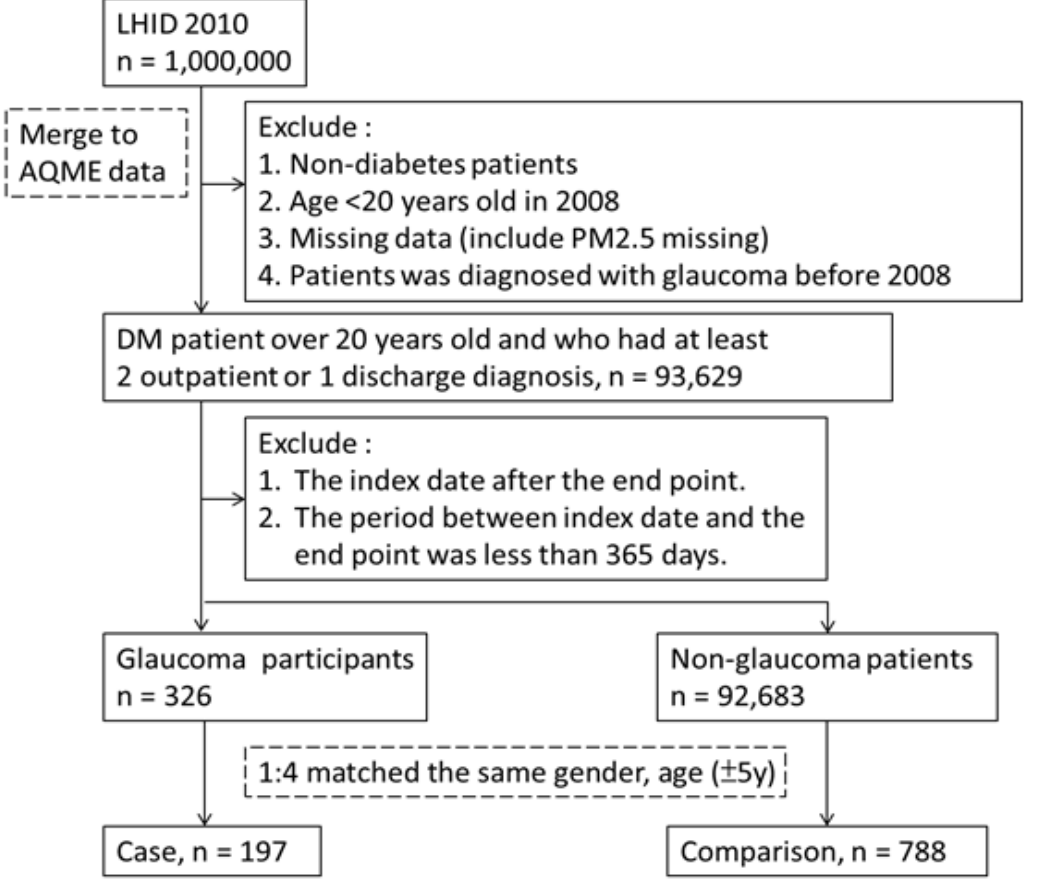
Figure 1. Flow chart of diabetes patients.